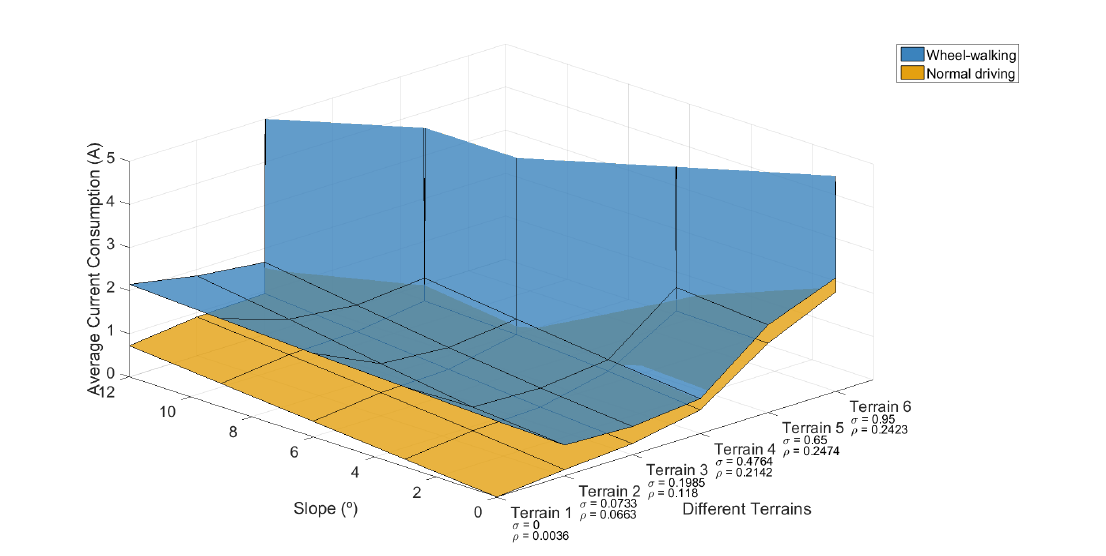
Figure 9. Average current consumption of wheel walking and normal driving locomotion modes on different terrains. It is always lower in normal driving, however, the difference is decreased as σ and ρ are